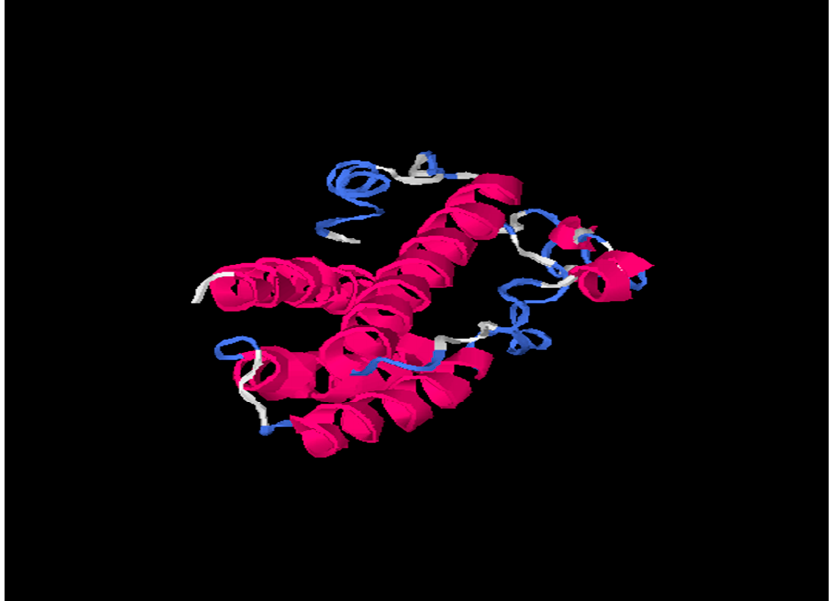
Figure 4. 701347 (HBV_800 isolate) tertiary structure using I-Tasser online software. Pink is alpha- helix; Blue is coil and white region is extended